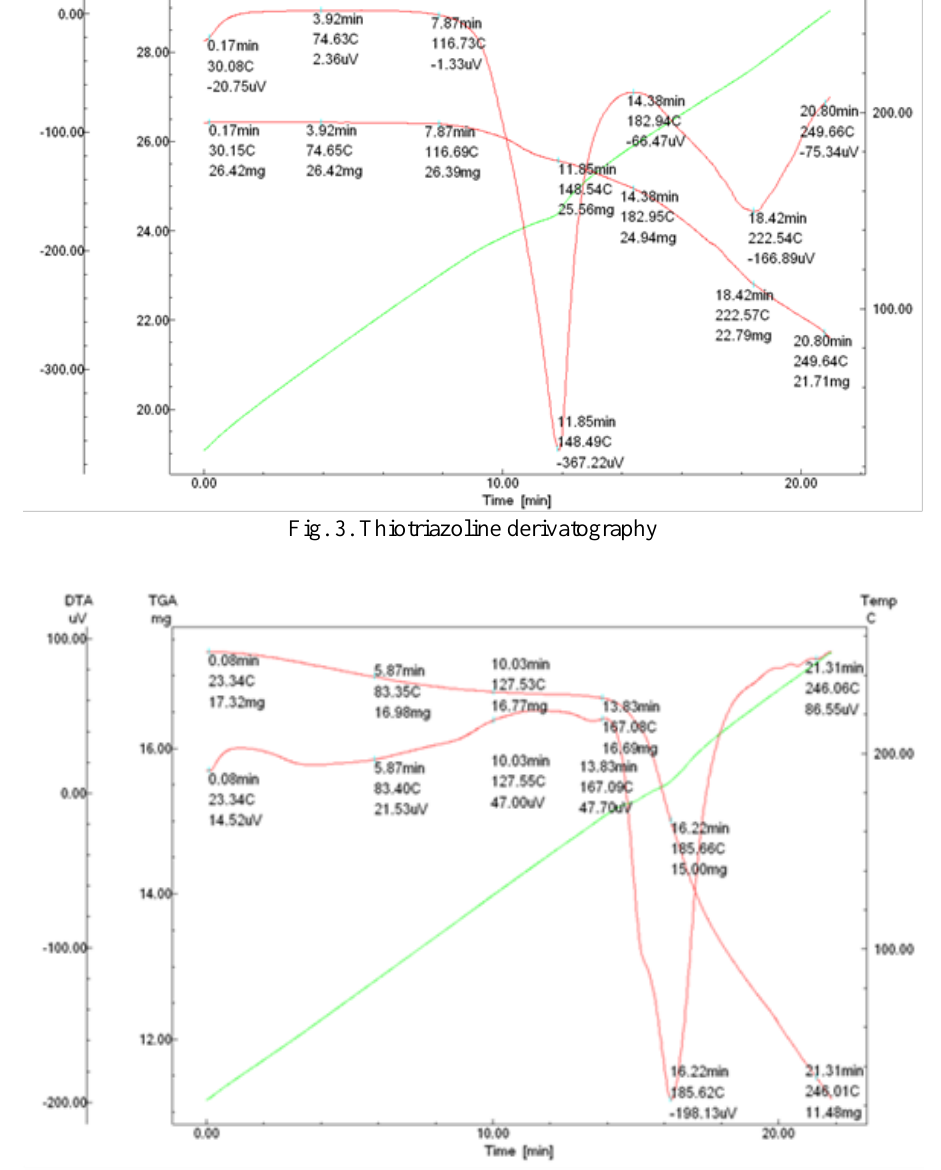
Fig. 4. Decamethoxin